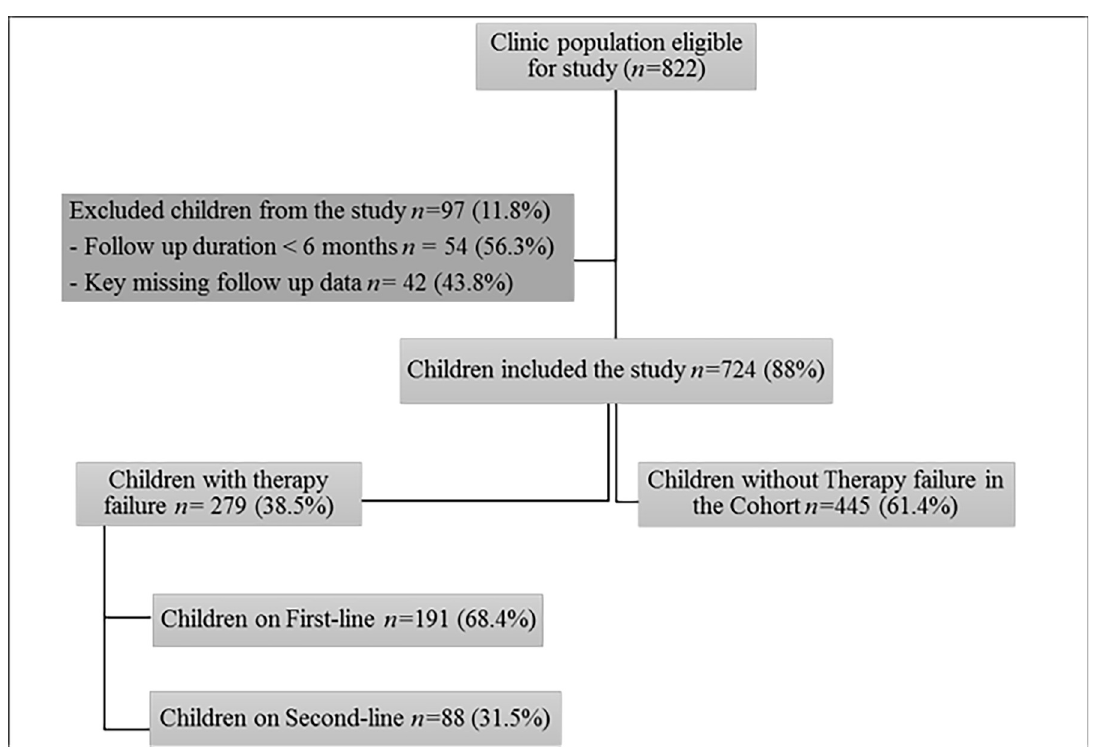
Fig 1. Flow diagram of study recruitment and outcomes in children receiving cART in National Referral Pediatric Follow-up Clinic, 2005–2020.